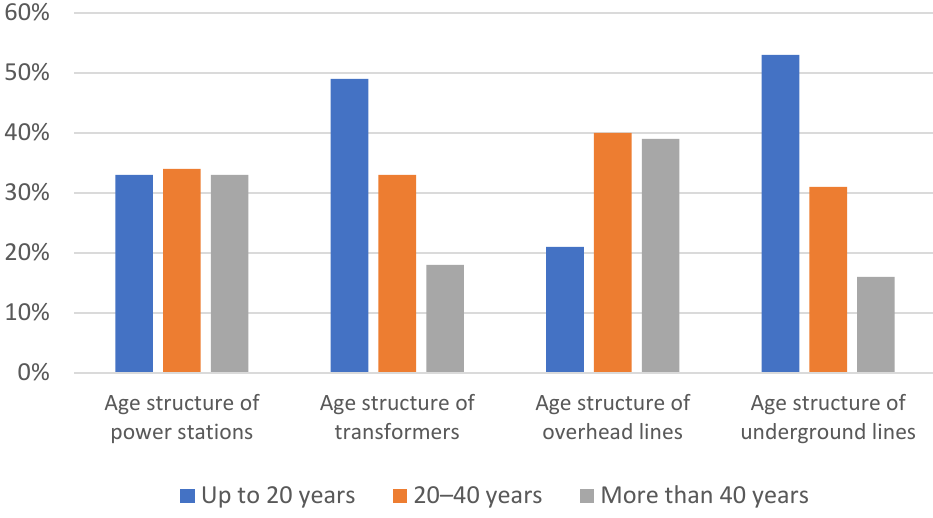
Figure 3. Age structure of Poland’s power infrastructure [38].